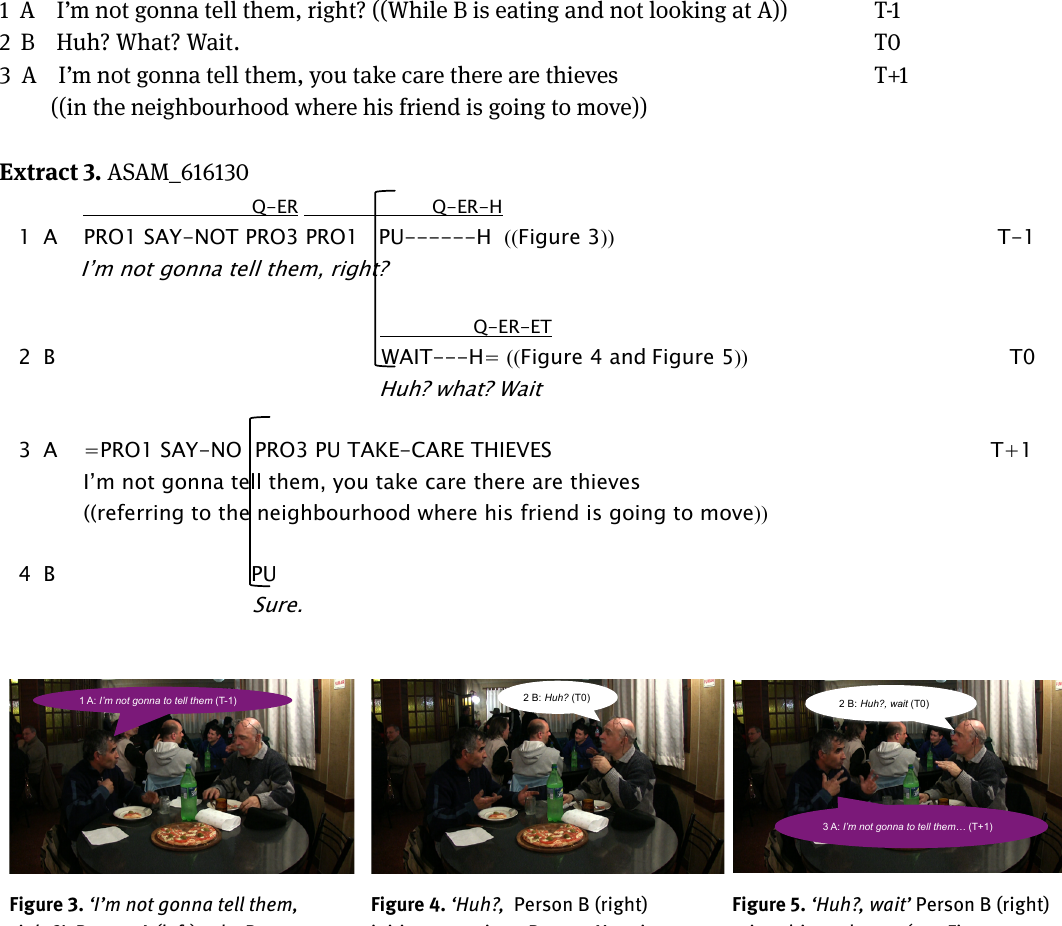
Figure 5. ‘Huh?, wait’ Person B (right) raises his eyebrows (see Figure 4); second he brings his eyebrows together and raises his left hand ‘Wait’ (line